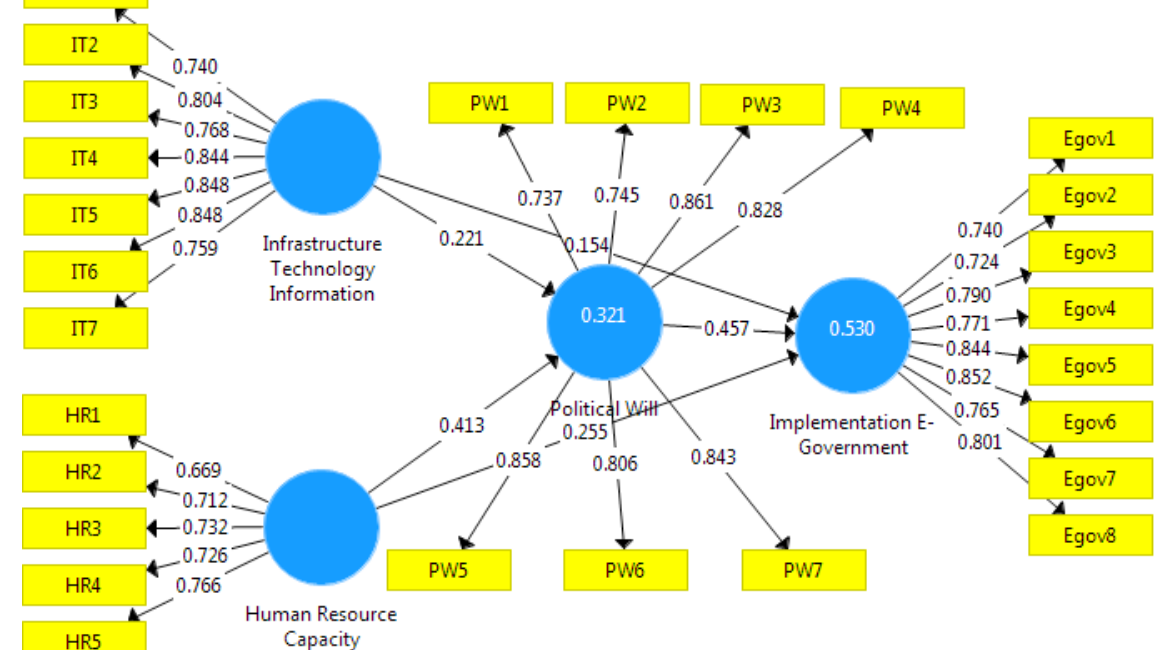
Figure 2. Convergent validity